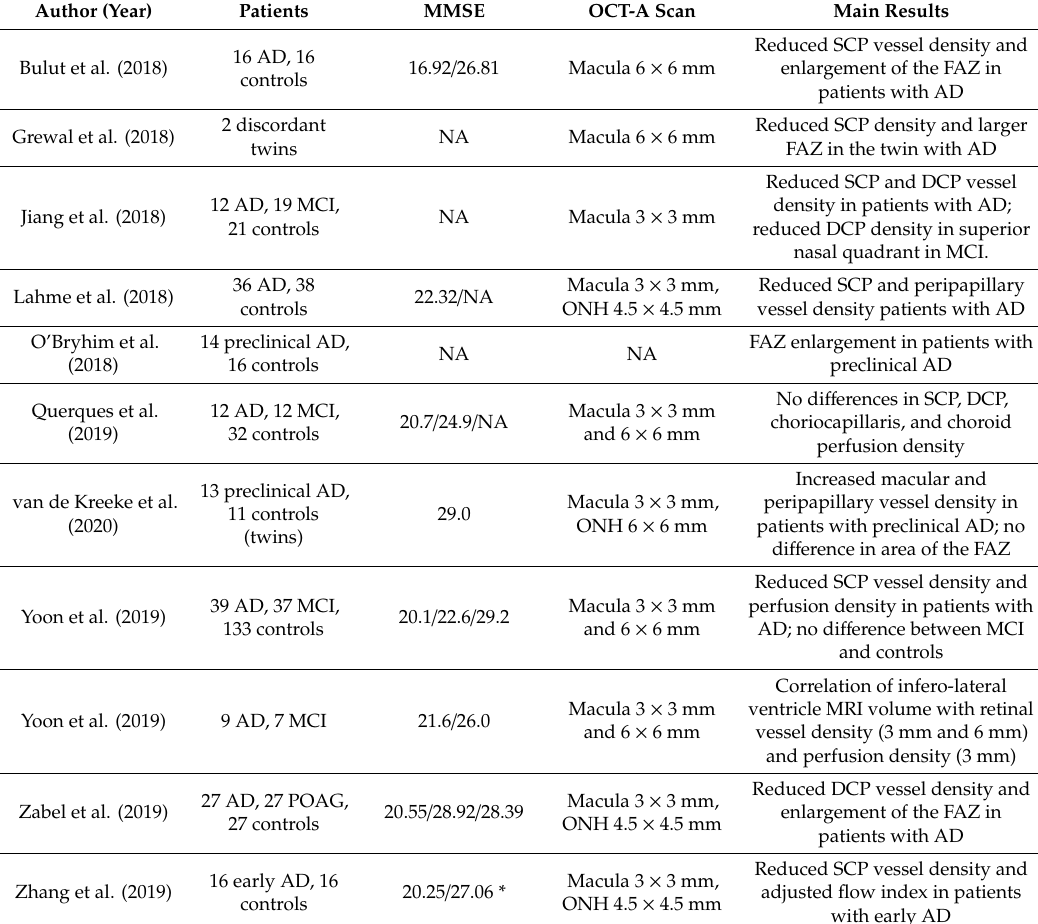
Table 1. Characteristics of studies evaluating ocular coherence tomography angiography in patients with Alzheimer’s